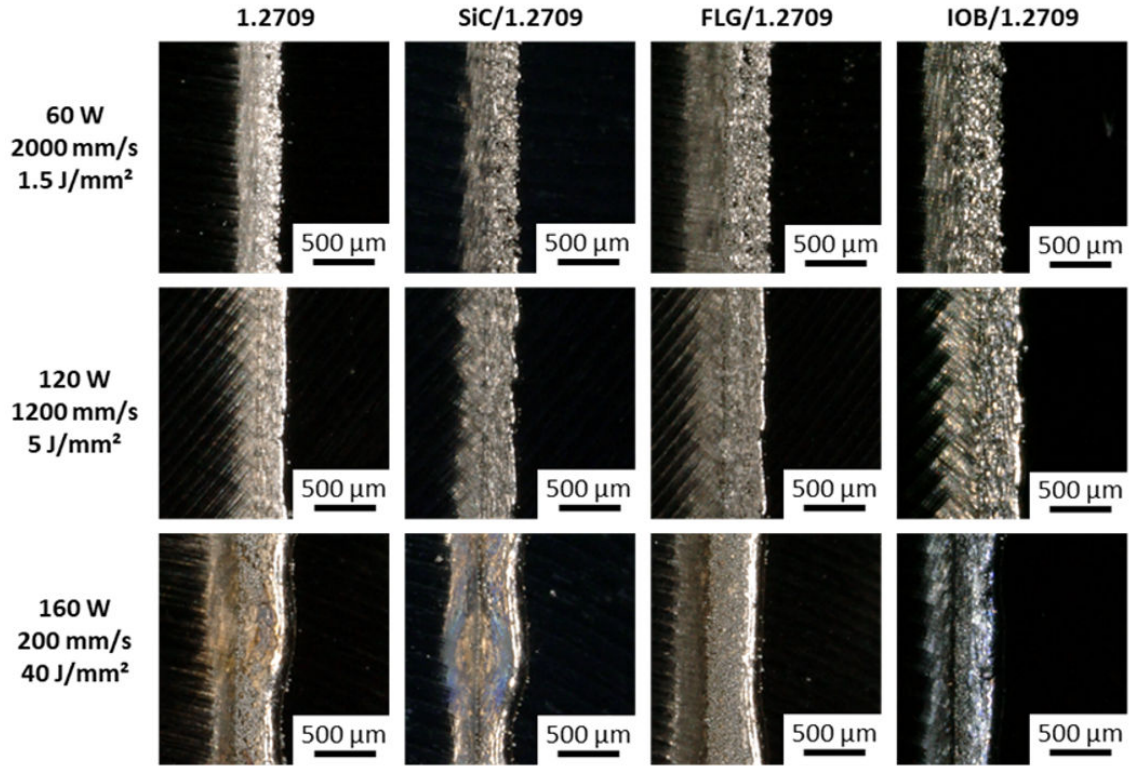
Figure 8. Side view of the single track of 1.2709, SiC/1.2709, FLG/1.2709, and